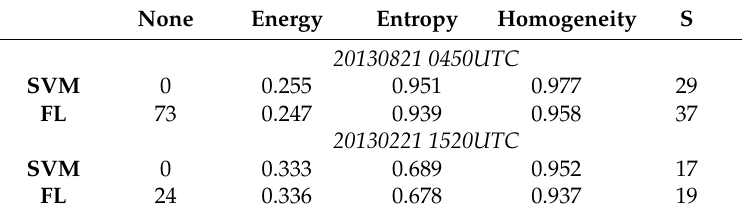
Table 4. As in Table 3, scores refer to two X-band classification maps shown in Figure 6 (upper lines) and Figure 7 (lower lines).